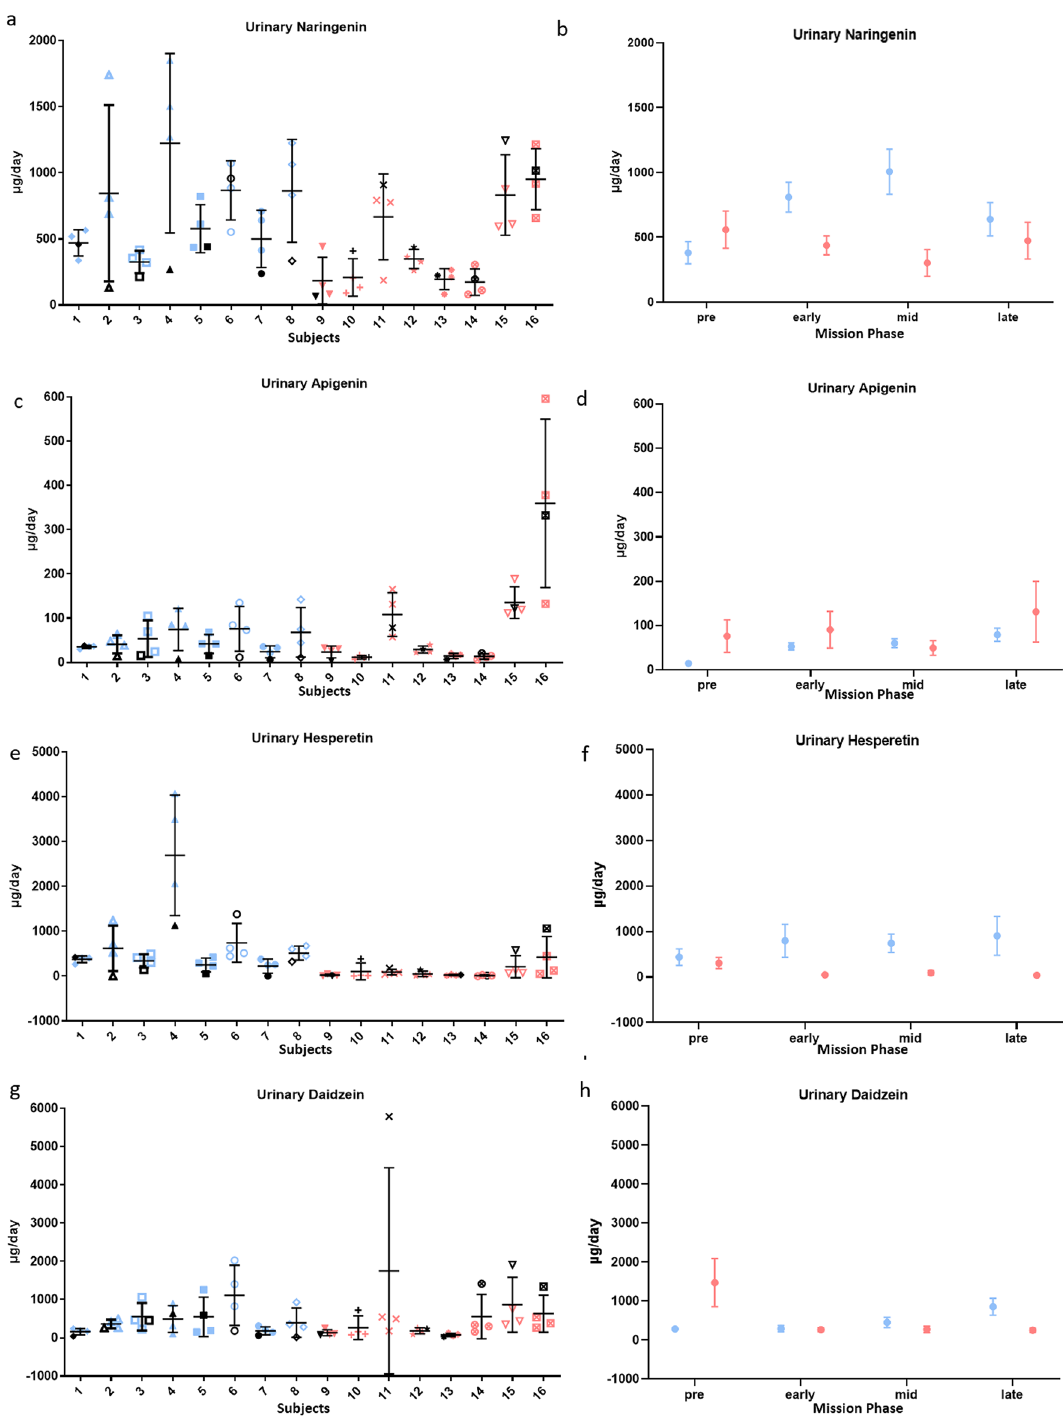
Figure 3. Urinary flavonoid status in-mission compared to pre-mission average. In ( a,c,e,g,i,k ) each vertical set of samples represents one individual on the enhanced diet (blue) or the standard diet (red). Black symbols denote individual pre-mission average. In ( b,d,f,h,j,l ) plots represent the mean ± SE of all subjects on the enhanced diet (blue) or the standard diet (red) during different phases of the mission. Urinary naringenin, apigenin, hesperetin, daidzein, genistein, and luteolin increased for subjects on the enhanced diet. More information is available in SI Appendix, Table